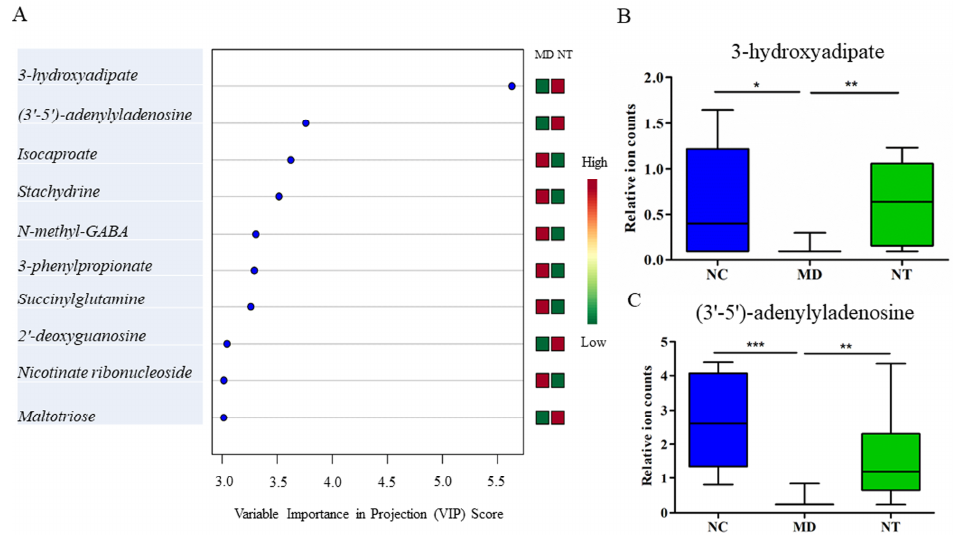
Figure 7. Important metabolites related to neoagarotetraose (NT) supplementation. A : Metabolite predictors discriminative of NT supplementation status based on variable importance in projection scores. B : NT supplementation significantly reversed the 3-hydroxyadipate concentrations from a repressed level in DSS induced colitis mice. C : NT supplementation restored the (3’–5’)- adenylyladenosine repressed by DSS to the basal level observed in normal controls. NC: normal controls; MD: colitis induced by DSS; NT: DSS-induced colitis mice supplemented with NT. ** p < 0.01; *** p < 0.001.